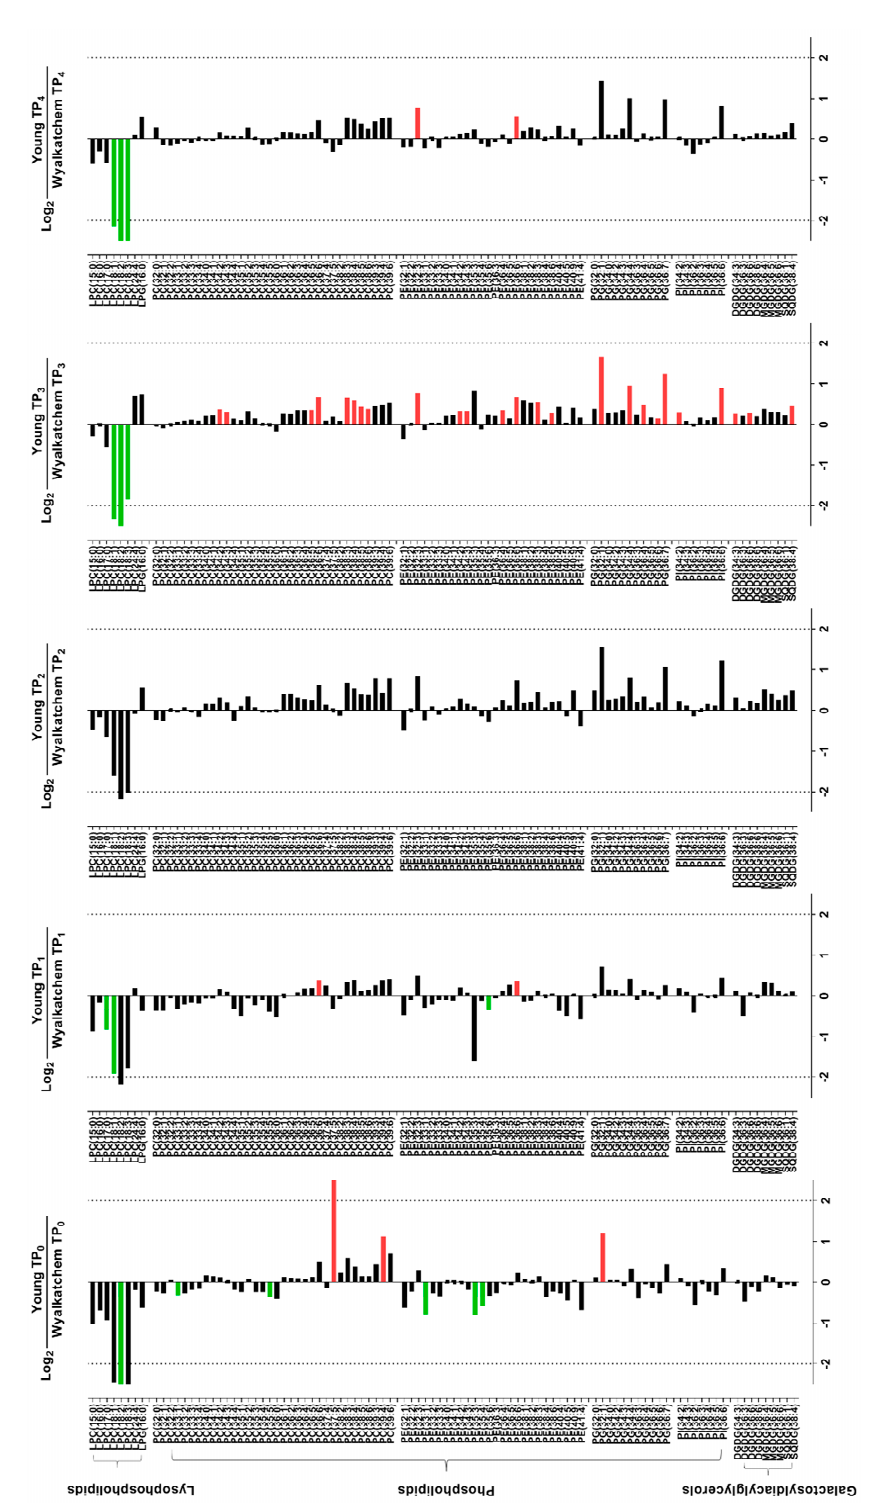
Figure 4. Log 2 -fold changes of lipids in the spikes of cold-tolerant Young (Y) compared to cold-sensitive Wyalkatchem (W) at each time point. Fold changes were calculated by dividing the concentration of Young by the concentration of Wyalkatchem at each time point, followed by log 2 -transformation. FDR-adjusted p -value of 0.05 was set as the cut-off. Green = significantly lower in Young, or higher in Wyalkatchem; red = significantly higher in Young, or lower in Wyalkatchem. n = 3.